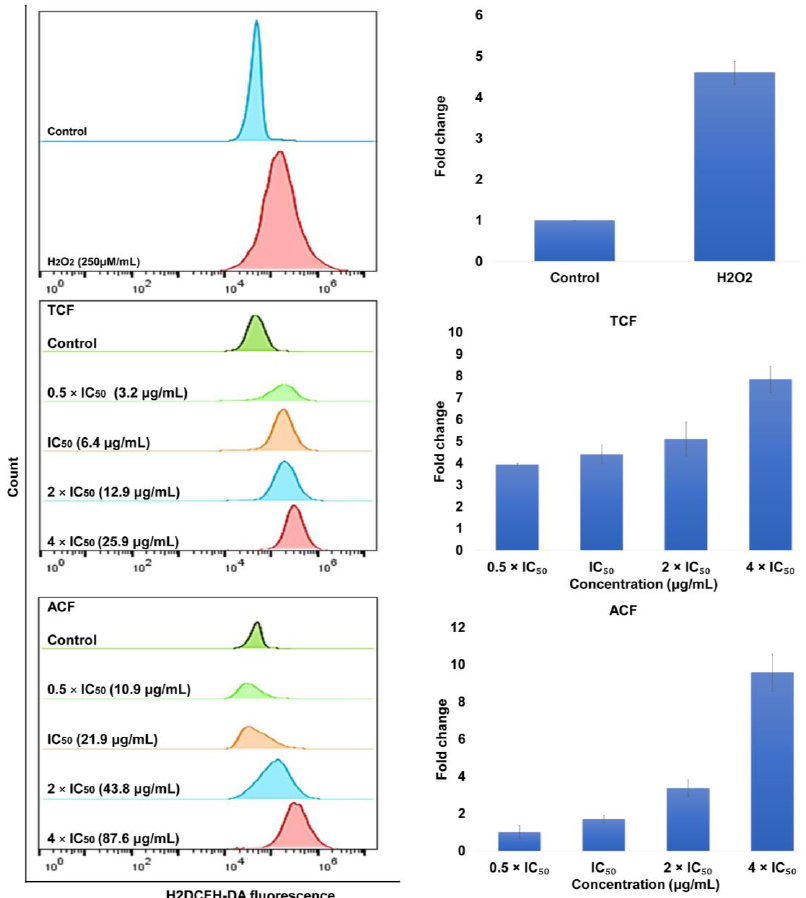
Figure 3. Intracellular production of reactive oxygen species in NCI-H929 cells. Results following 1 h incubation with 0.5, 1, 2, 4 × IC 50 of chloroform fractions of T. vulgaris (TCF) and A. lappa (ACF), stained with 2′,7′-dichlorodihydrofluorescein diacetate (H2DCFH-DA) and analyzed by flow cytometry. Control: NCI-H929 cell without treatment.